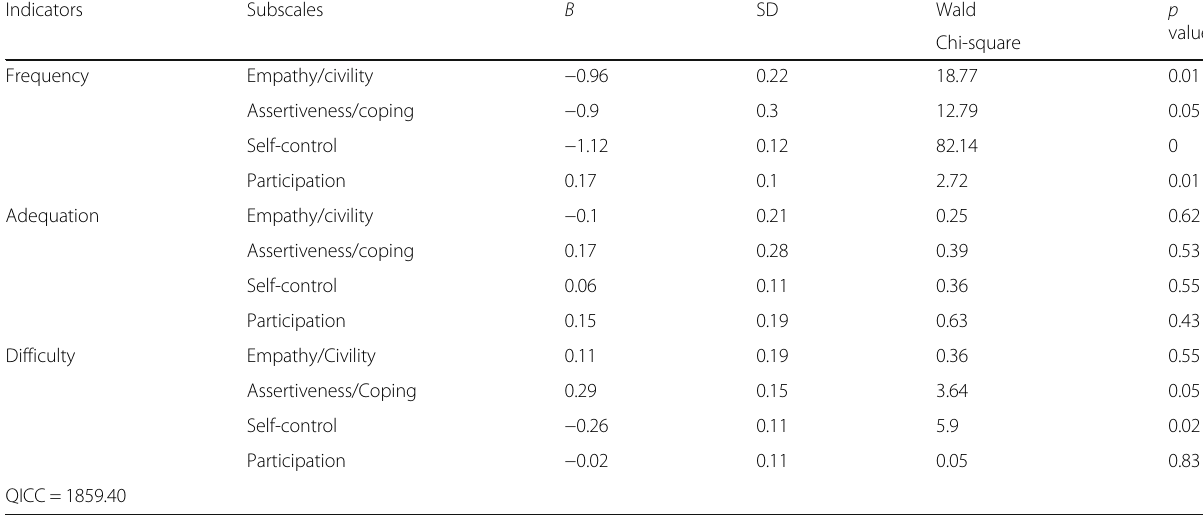
Table 6 GLZMM model with Gamma distribution with social skills as a function of group treatment (multimodal group)